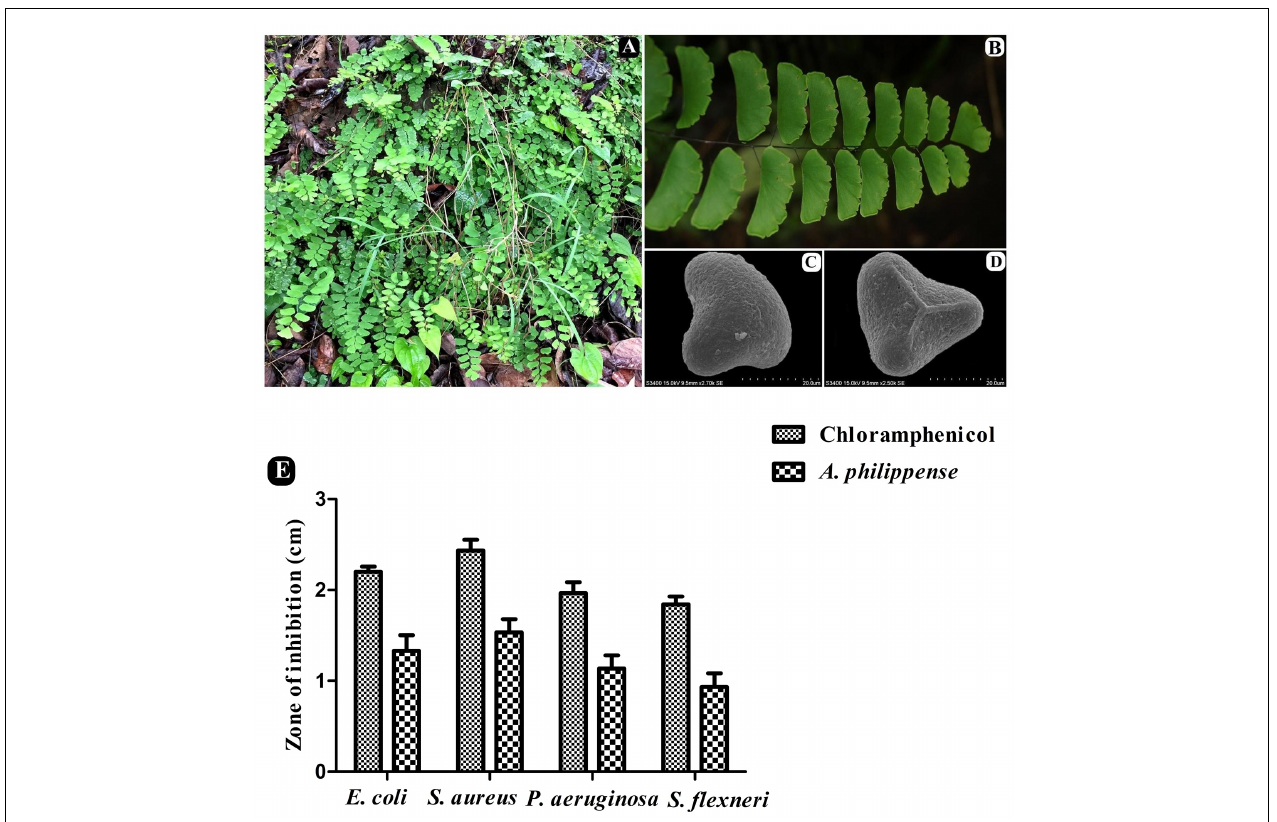
FIGURE 1 | A. philippense plant and its antibacterial activity. (A) Plants in wild; (B) close up of frond; (C) distal face of spore under SEM; (D) proximal face of spore under SEM; and (E) antibacterial activity against E. coli , S. aureus , P. aeruginosa , and S. flexneri . All experiments were carried out in triplicate, and data represent the mean ± SD.